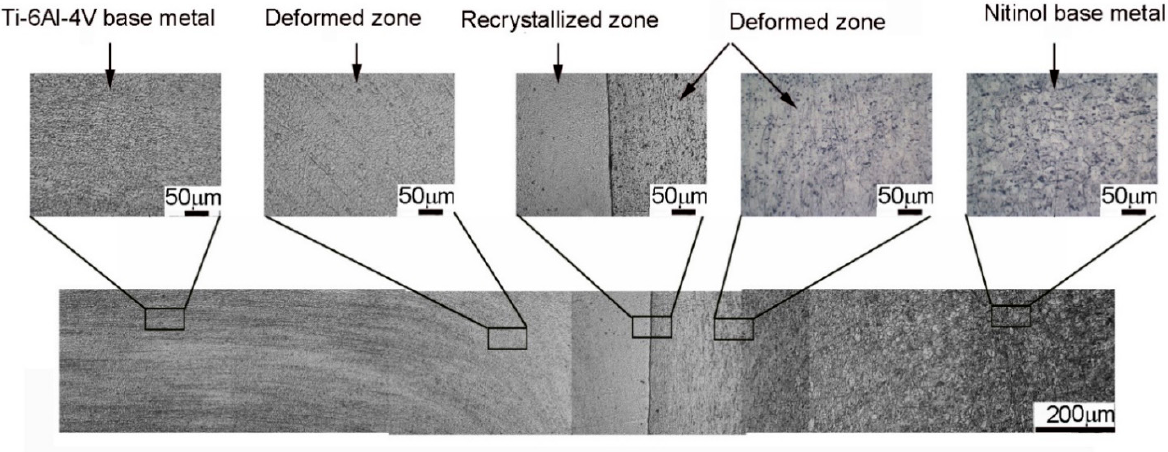
Figure 7. The optical microstructure of the Ti-6Al-4V/Nitinol linear friction welds in the post-weld, heat-treated (PWHT) condition.